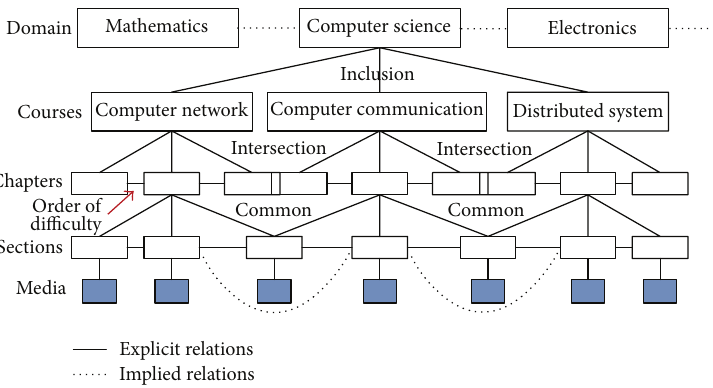
Figure 9: The relations of partial media data.